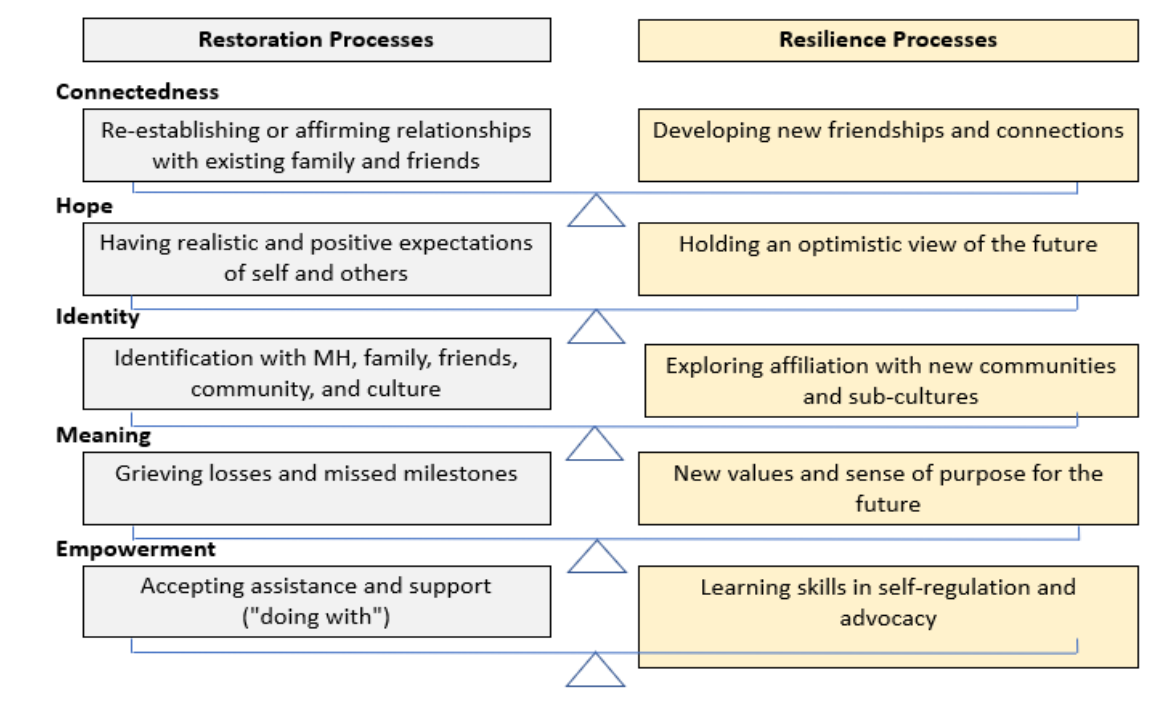
Figure 2. Restoration and resilience processes for youth recovery.